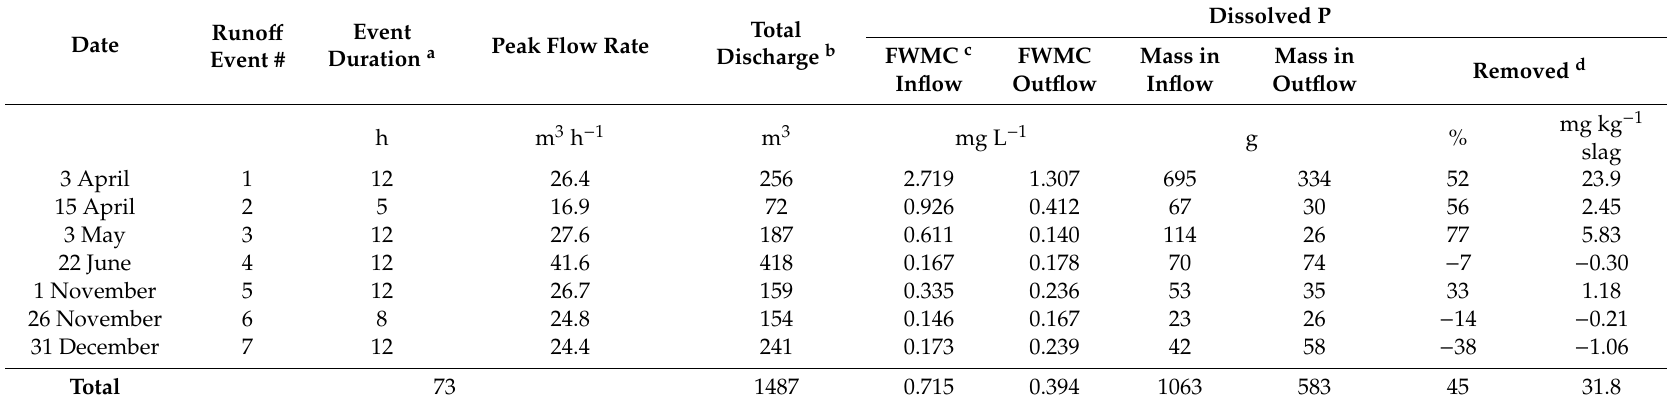
Table 4. Dissolved phosphorus (P) removal, concentrations and loads at the inlet and outlet, and flow characteristics for each runo ff event at the blind